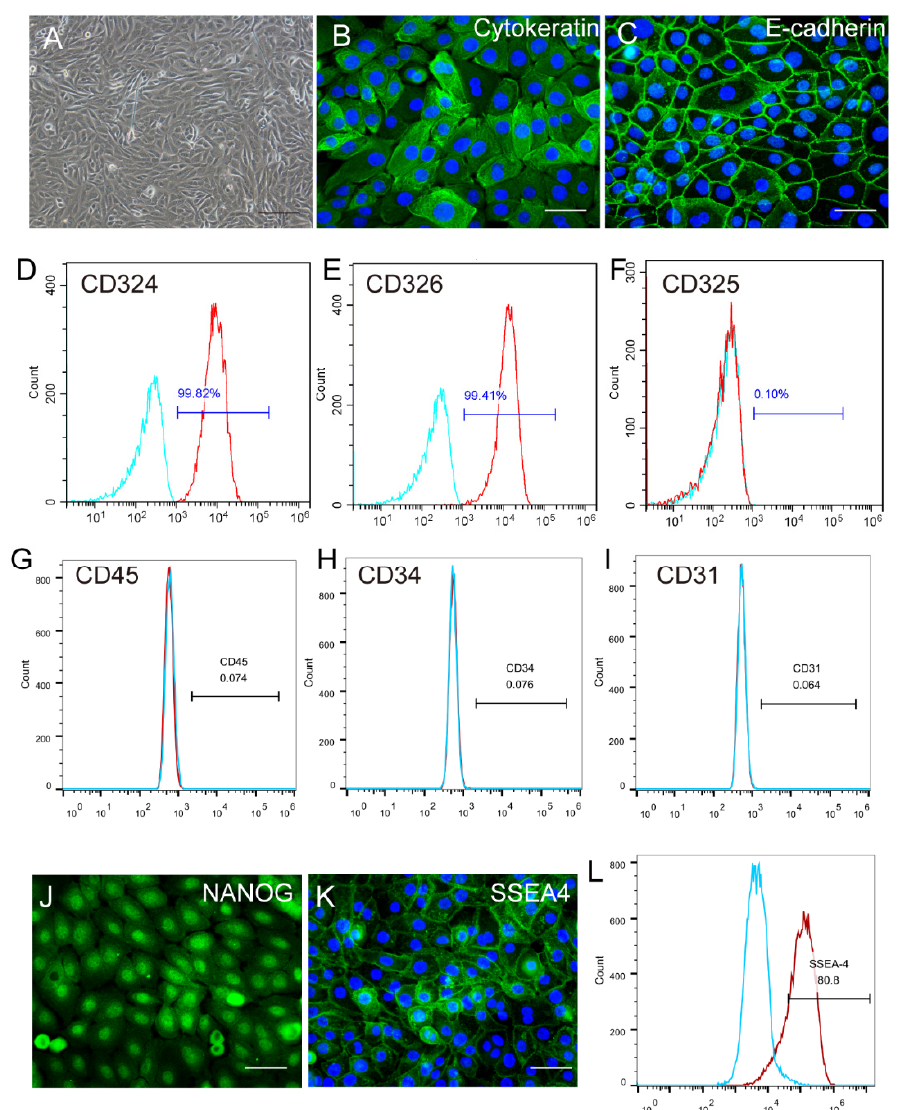
Figure 1. Characteristics of human amniotic epithelial stem cells (hAESCs). ( A ) Phase–contrast microscope image showing isolated hAESCs as a homogeneous population with cobblestone appearance. ( B – E ) Nearly all cells showed persistent expression of the representative epithelial marker cytokeratin, E–cadherin (CD324), and E–pcam (CD326) by immunofluorescence and flow cytome-